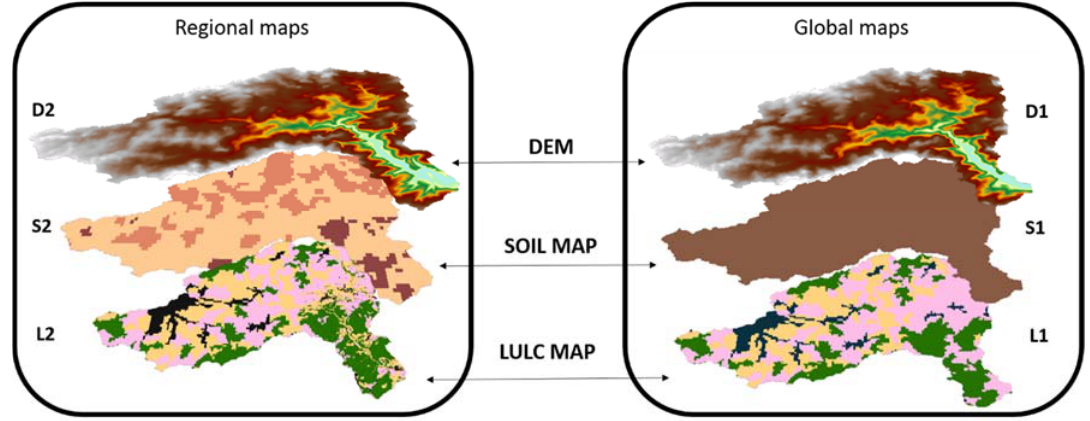
Figure 2. Regional and global datasets for the study area: digital elevation model (DEM), soil, and land use/land cover (LULC) maps. Detailed input data maps (D2, S2, and L2) are compared with global maps (D1, S1, and L1) and cross ‐ combined into eight different model setups.